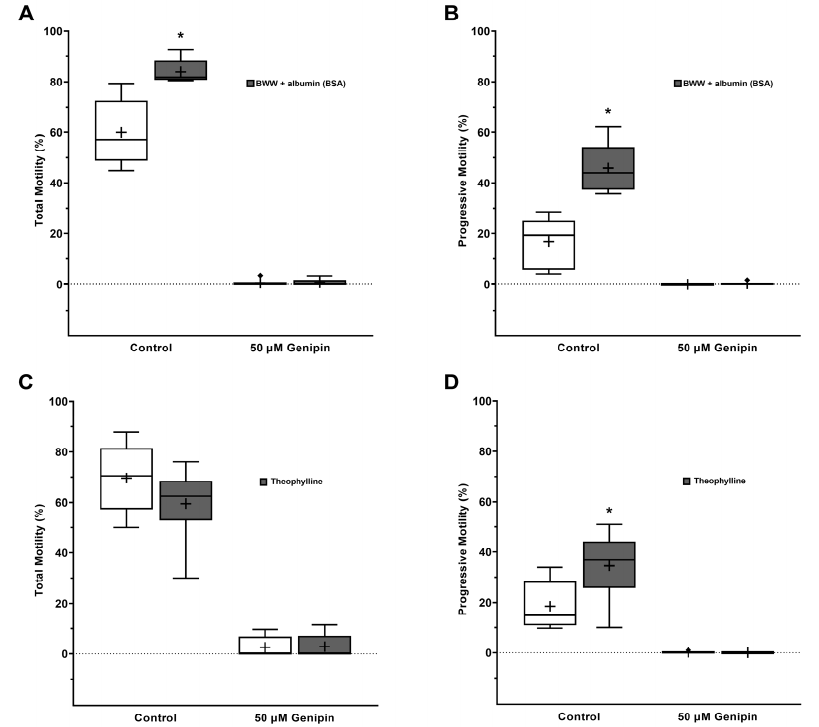
Figure 5. Evaluation of motility loss reversibility conferred by UCPs inhibition with 50 µM genipin. ( A ) Total and ( B ) progressive motility of genipin-treated spermatozoa upon wash and 45 min